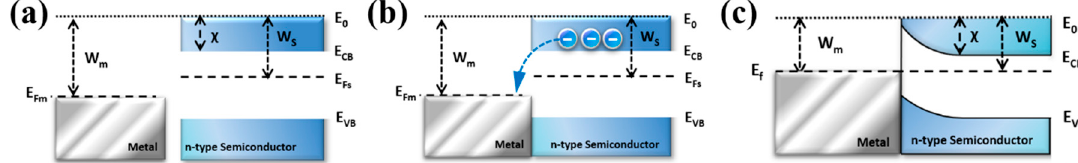
Figure 1. Process of the formation of the Schottky contact. ( a ) The band diagram before coming into contact with the metal and n-type semiconductor. ( b ) The flow of electrons from the n-type semiconductor to the metal and ( c ) the final equilibrium attainment with the bending of the band after contact.